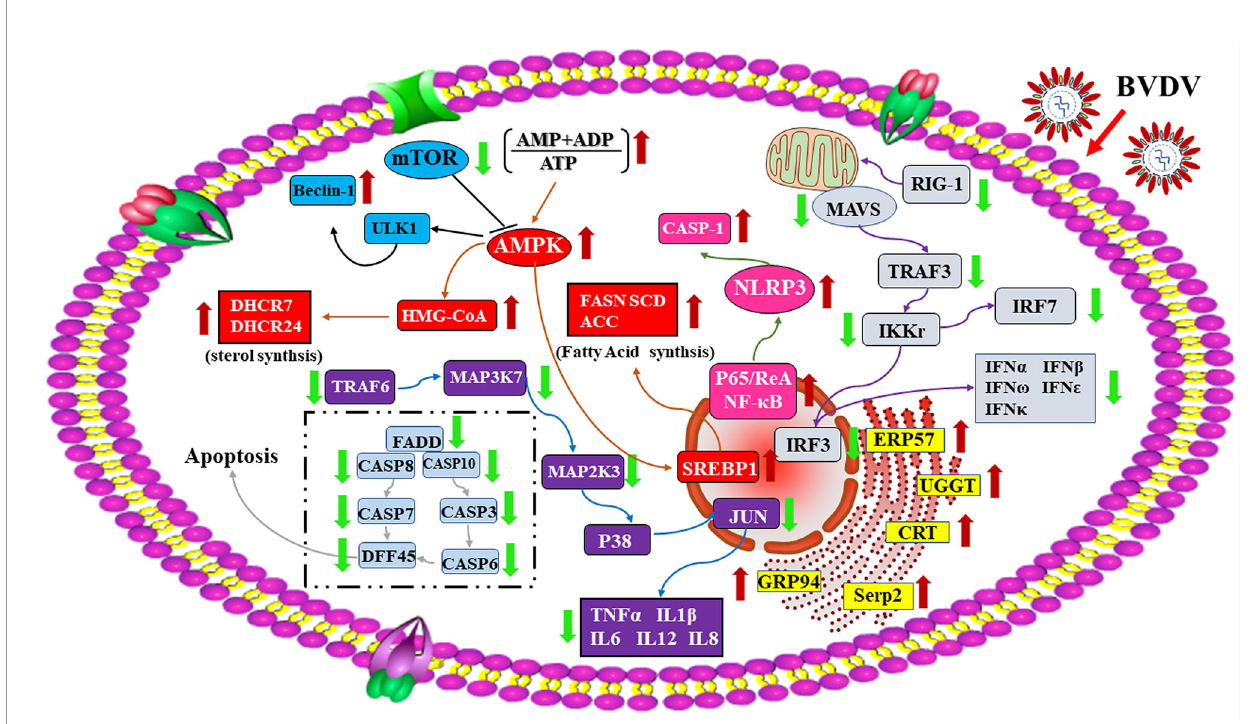
FIGURE 10 | A global overview of the major signaling pathway involved in BVDV-MDBK cell interactions. The red arrow represents up-regulated DEPs, and the green arrow represents down-regulated